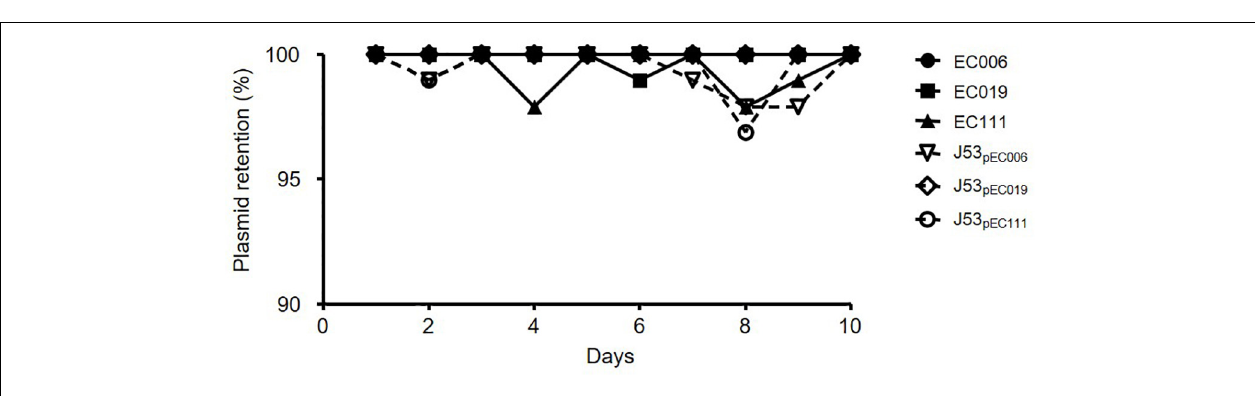
FIGURE 2 | Plasmid stability of mcr-1 -harboring E. coli strains. Plasmid stability was determined by colony picking onto selective media in 96-well plates and is presented as a percentage of the wells with bacterial growth on media with